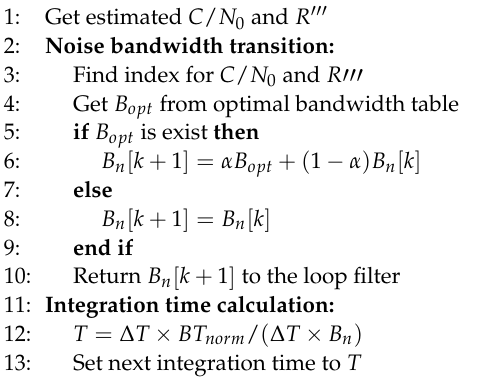
Algorithm 2 Table-based adaptive DPLL